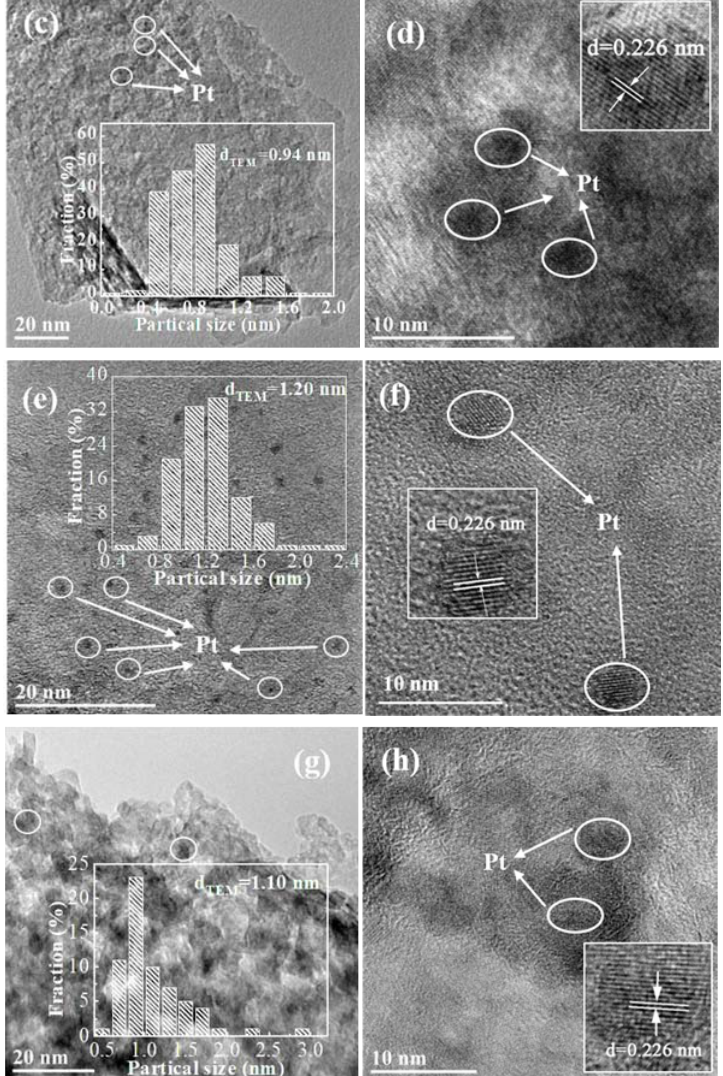
Figure 3. TEM images, HR ‐ TEM and the statistics of PSD in the insets of PtIn/MAZ catalytic system reduced with di ff erent atmospheres: ( a , b ) H 2 / N 2 ; ( c , d ) C 3 H 8 / H 2 / N 2 ; ( e , f ) C 3 H 8 ; ( g , h ) CO (reduction conditions: T = 600 º C, t = 2.5 h).